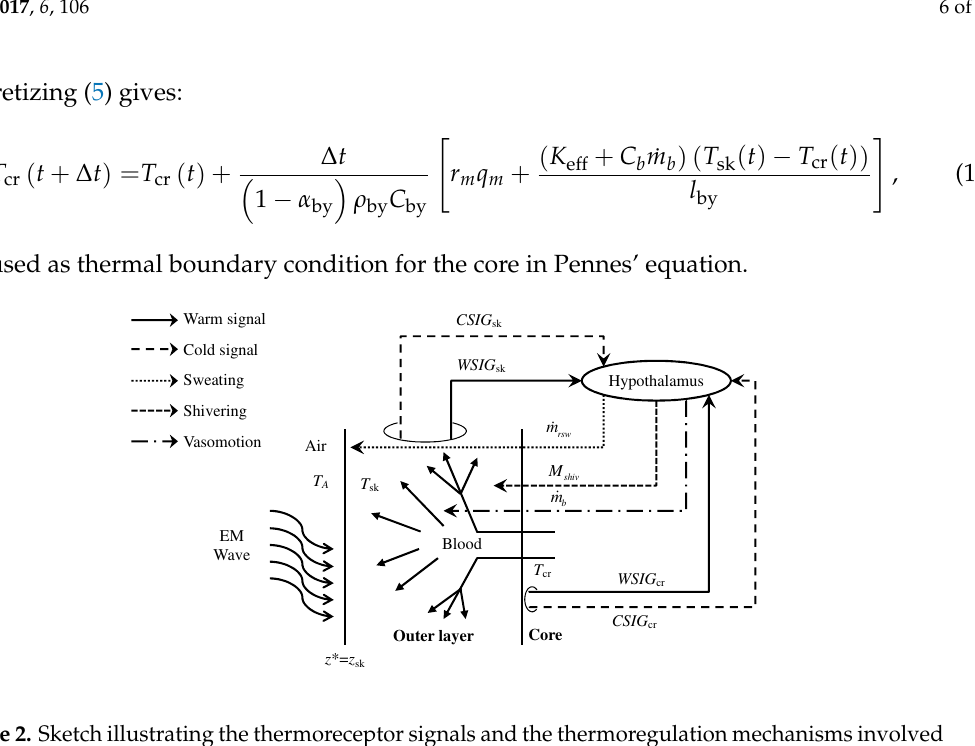
Figure 2. Sketch illustrating the thermoreceptor signals and the thermoregulation mechanisms involved in Gagge’s two-node